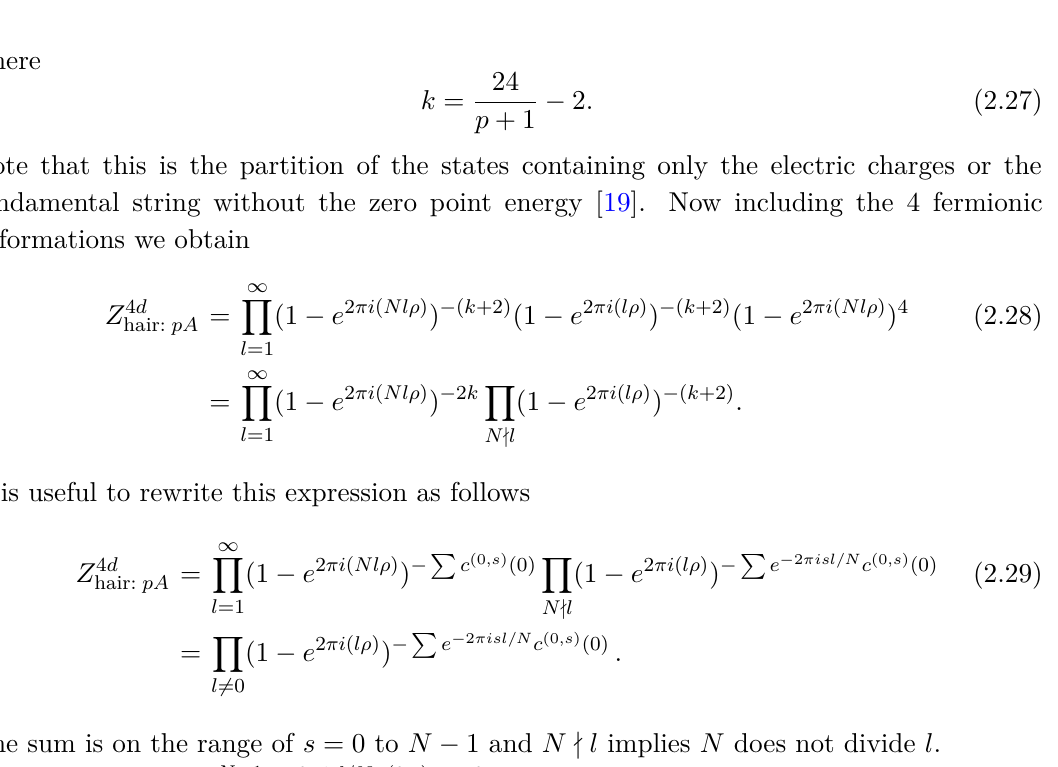
Table 1 . Values of P N − 1 e − 2 πisl/N c (0 ,s ) ( − b 2 ) for orbifolds of K 3 with prime order ( N = p ) s =0